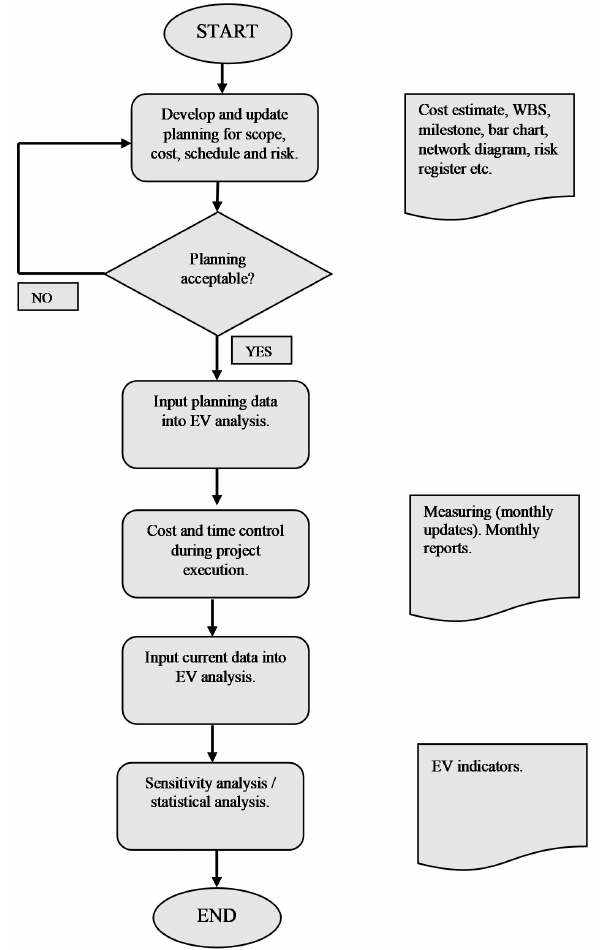
Figure 1: Flowchart of earned value analysis [authors’